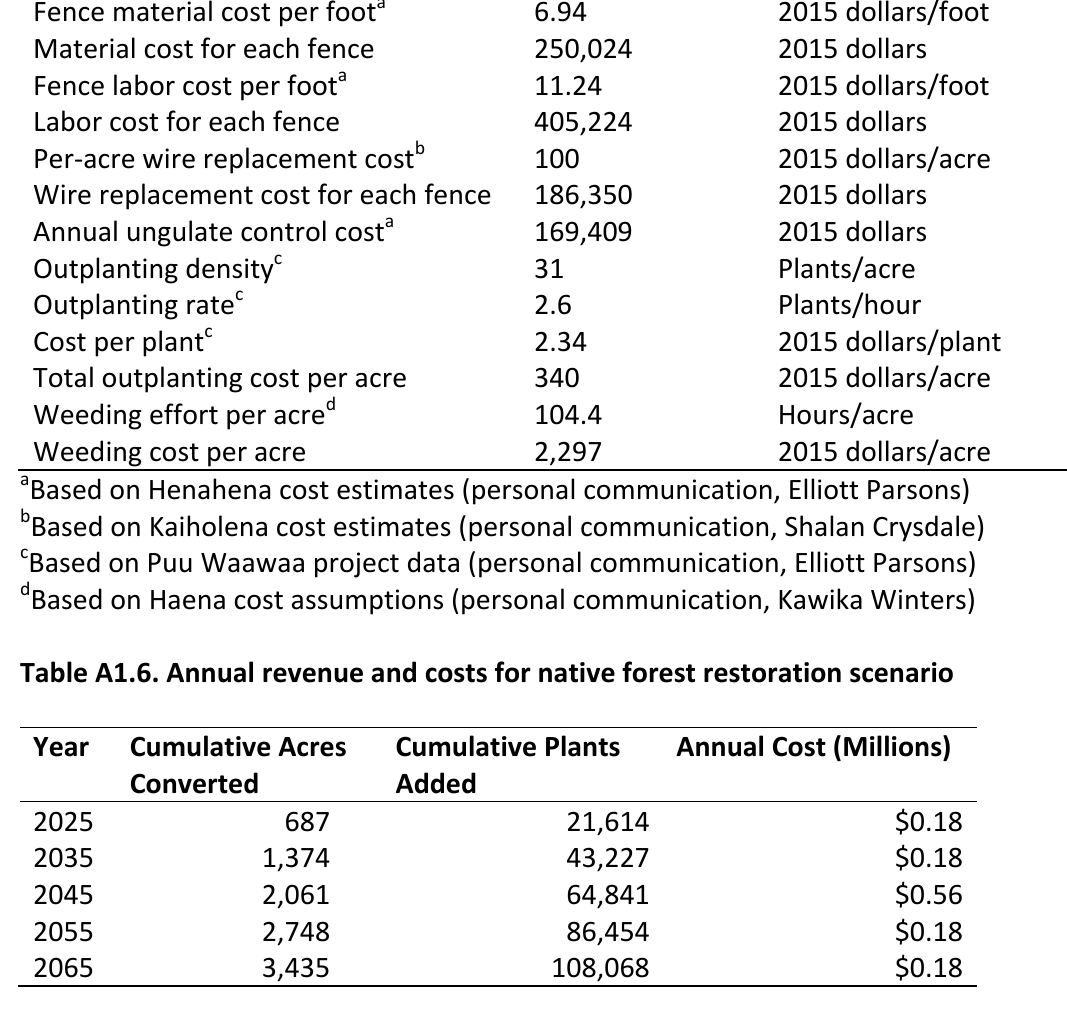
Table A1.7. Parameter descriptions and values for coffee scenarios Description